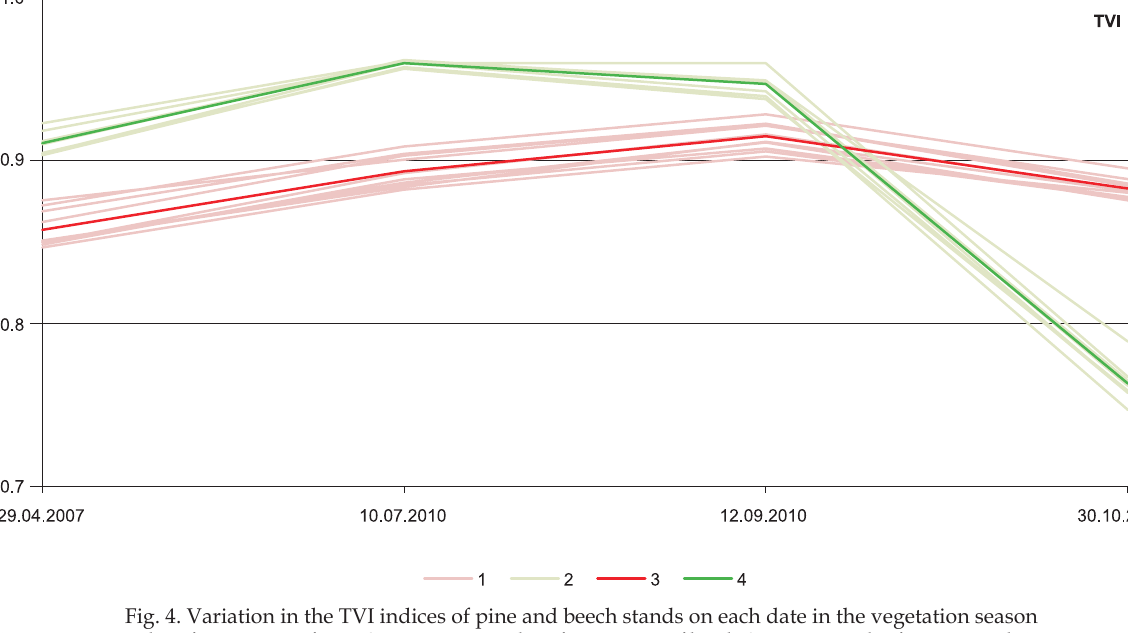
Fig. 4. Variation in the TVI indices of pine and beech stands on each date in the vegetation season 1 – variation in indices for test areas of pine; 2 – variation in indices for test areas of beech; 3 – average index for pine stand; 4 – average index for beech